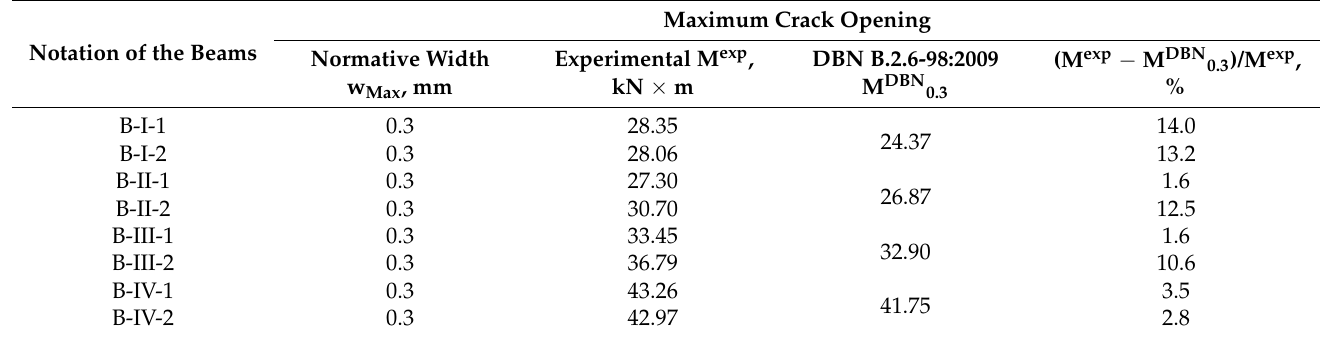
Table 4. Comparison of values of bending moments at maximum allowable crack